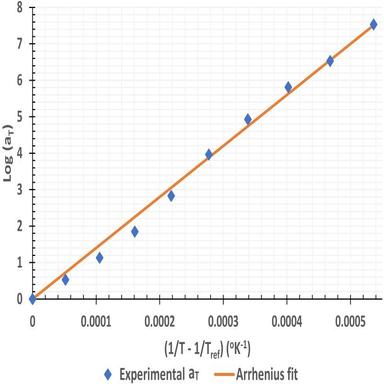
Arrhenius model fit to the experimental shift factors.